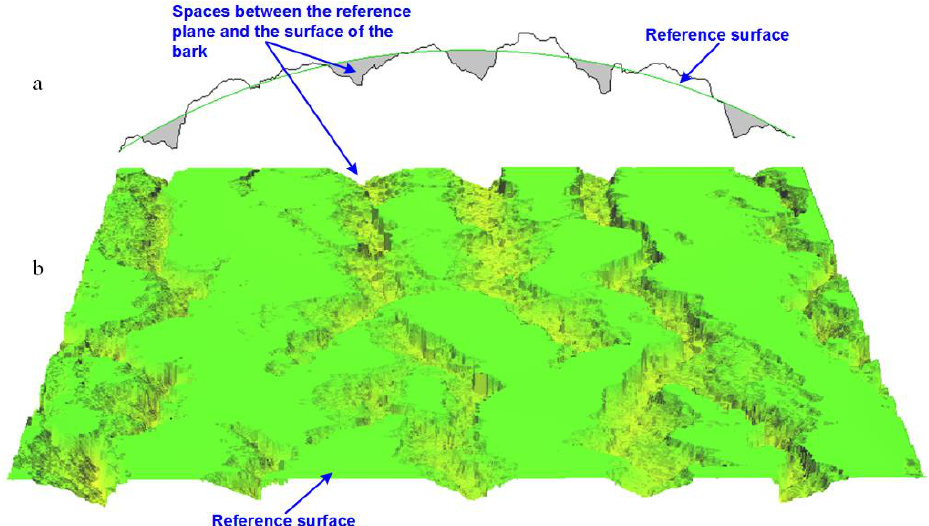
Figure 9. The fifth step in the analysis of the oak bark surface. ( a ) Defining the water-accumulating space. ( b ) A view of the reference plane and water-accumulating space in the measurement area 180 × 120 mm.